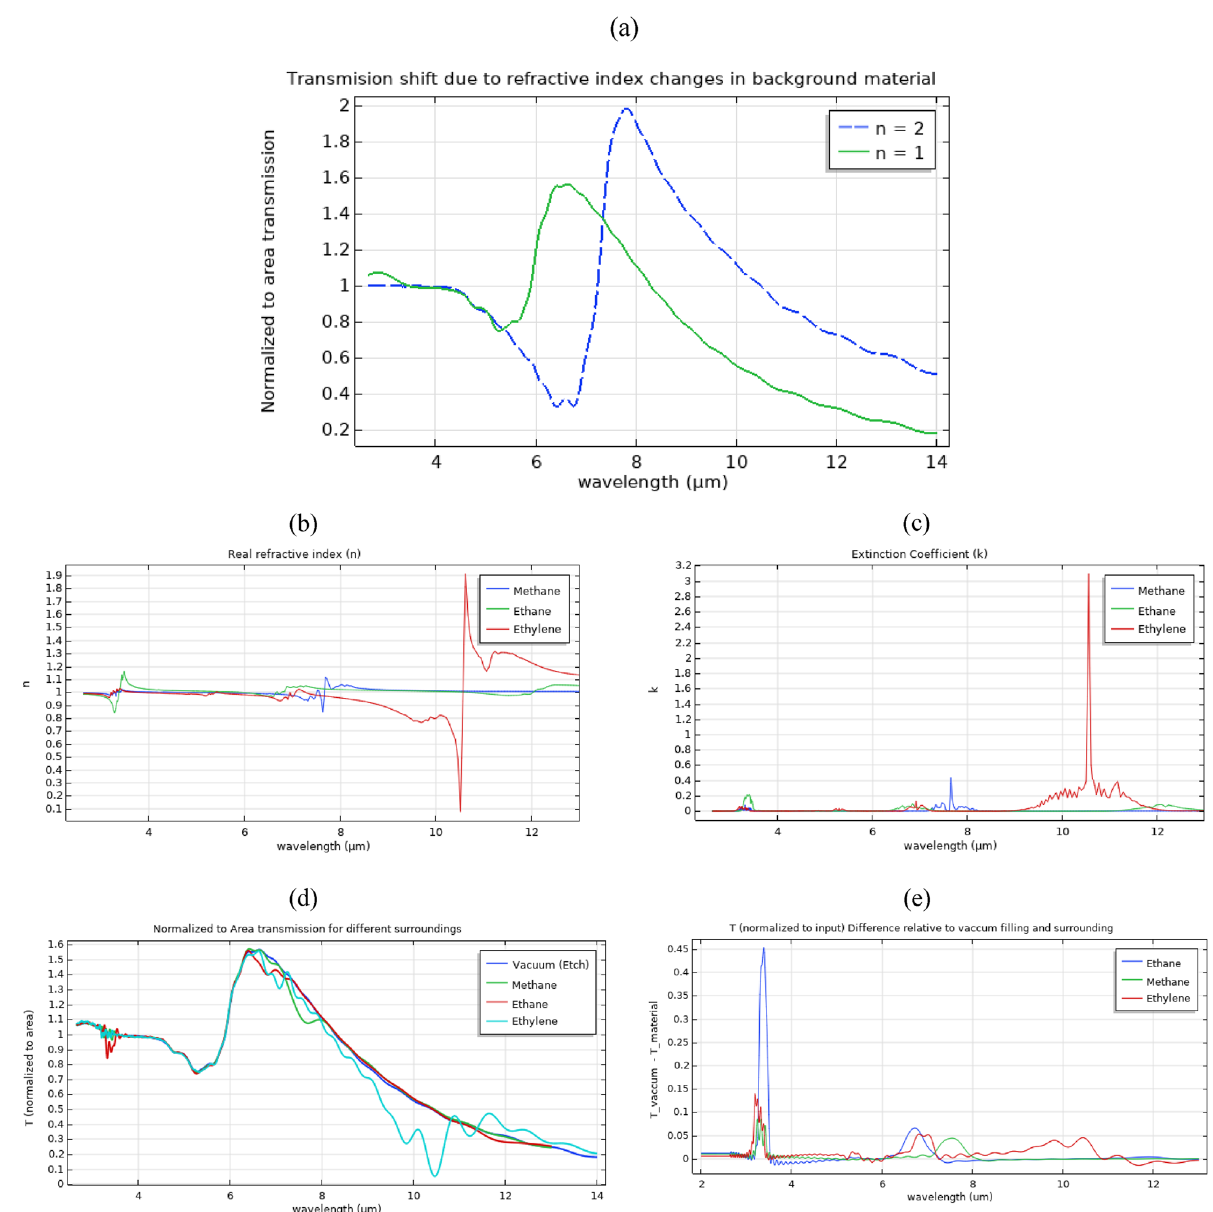
Figure 6. Analysis of the sensitivity of the calculated transmission to holes and surroundings material in a perforated Si thin film with generated excess carriers of 10 20 cm −3 concentration on a Sapphire substrate. ( a ) shows a redshift of 1170 nm in the transmission peak for 1 Refractive Index Unit (RIU) increase (i.e. from 1 to 2) in the holes filling and background material’s index indicating a sensitivity of ~ 1170 nm/RIU. ( b ) and ( c ) are the real and imaginary components of the complex refractive indices of Methane, Ethane, and Ethylene generated from their NIST transmission data 55 . In ( d ), normalized to area transmission through the perforated thin film for different surrounding materials and holes fillings are shown. Also as shown in ( e ), the differences in normalized (to input) transmission between the vacuum surroundings case and the case of Ethane, Methane, and Ethylene surroundings present more distinct fingerprints for recognizing the respective surrounding